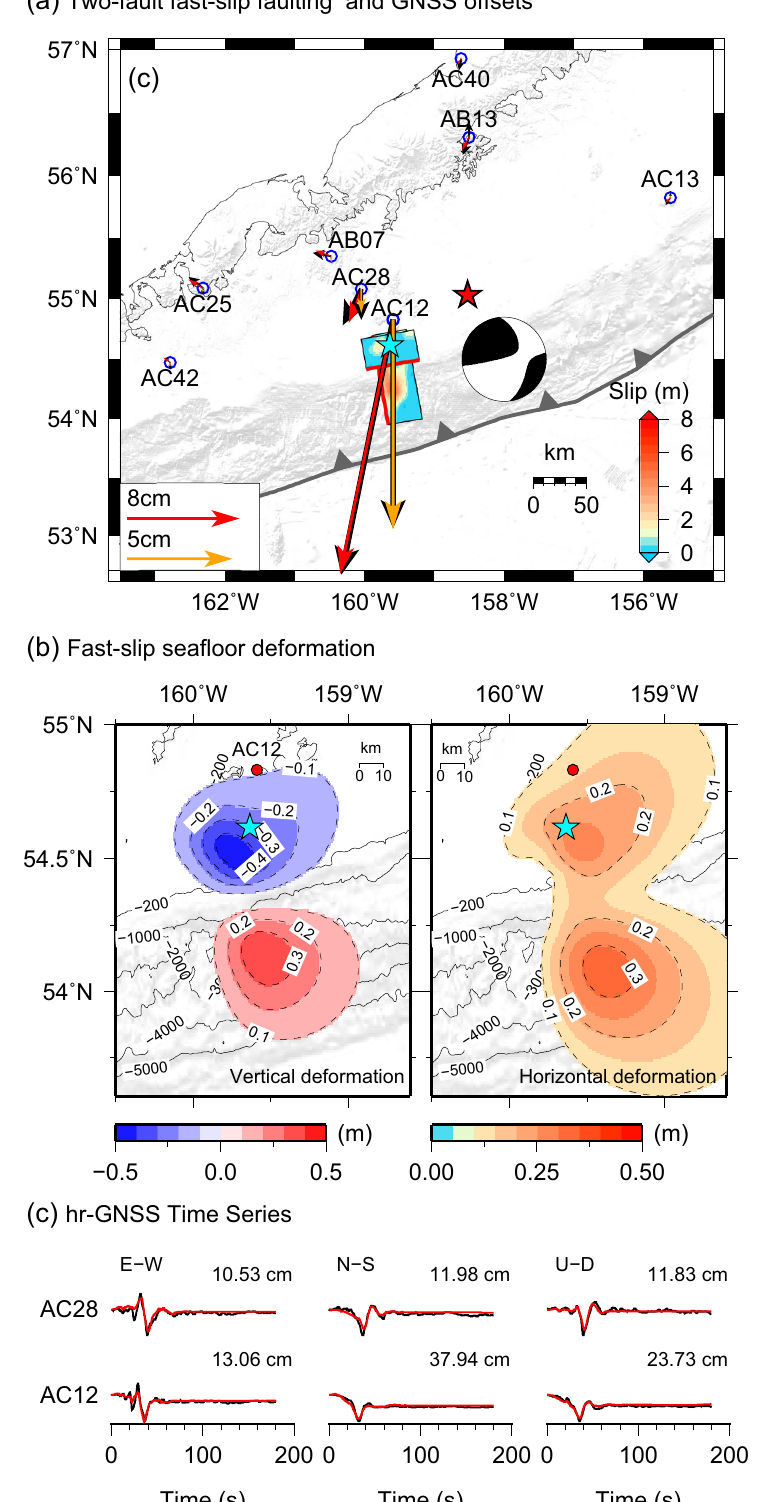
Fig. 3 | The two-fault fast-slip fi nite-fault model. a The slip distribution for two- faults is inverted from GNSS, regional broadband and strong-motion, and tele- seismic observations. The composite moment tensor for the two-fault model (black) is shown and matches the long-period solution in Fig. 1. Details of the slip distribution are shown in Supplementary Fig. 2c. GNSS coseismic offset observa- tions (black arrows) are compared with predictions (horizontal motions in red,